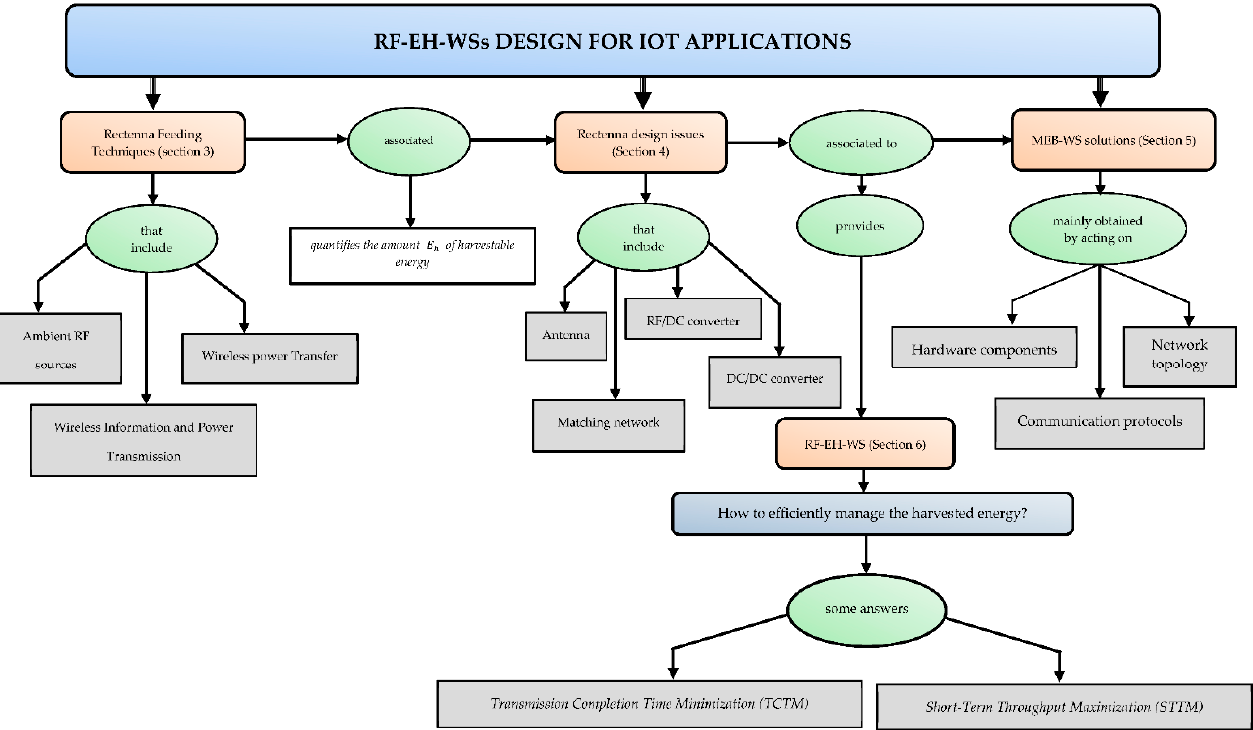
Figure 1. RF-EH-WS design considerations and paper